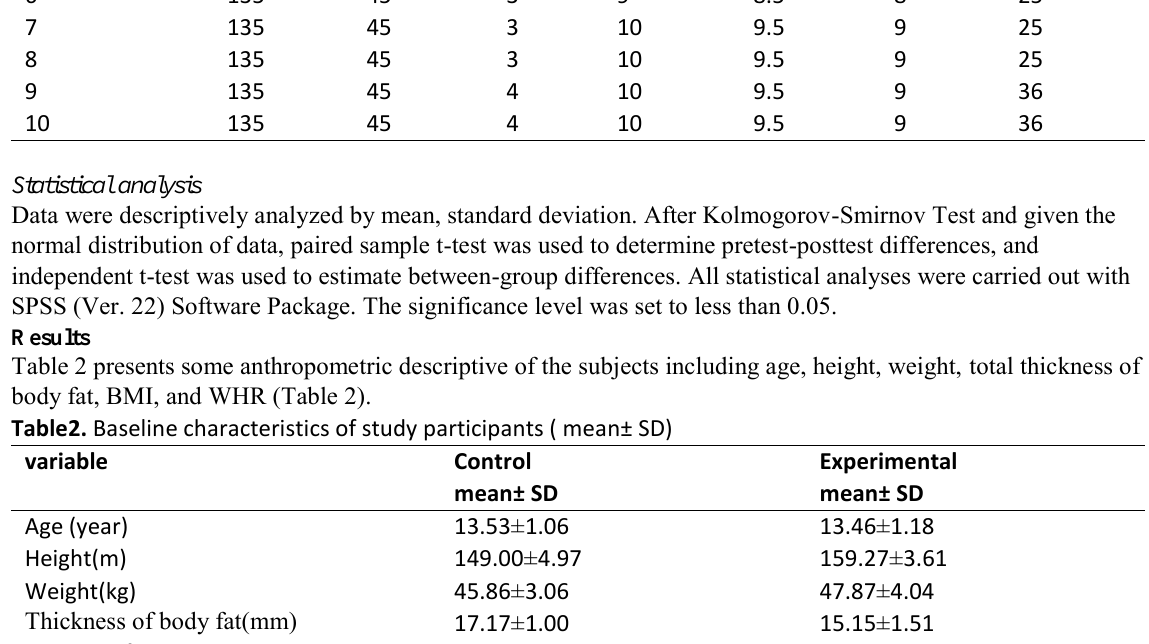
Table 3. Effects of HIIT training according paired t-tests (n=30)